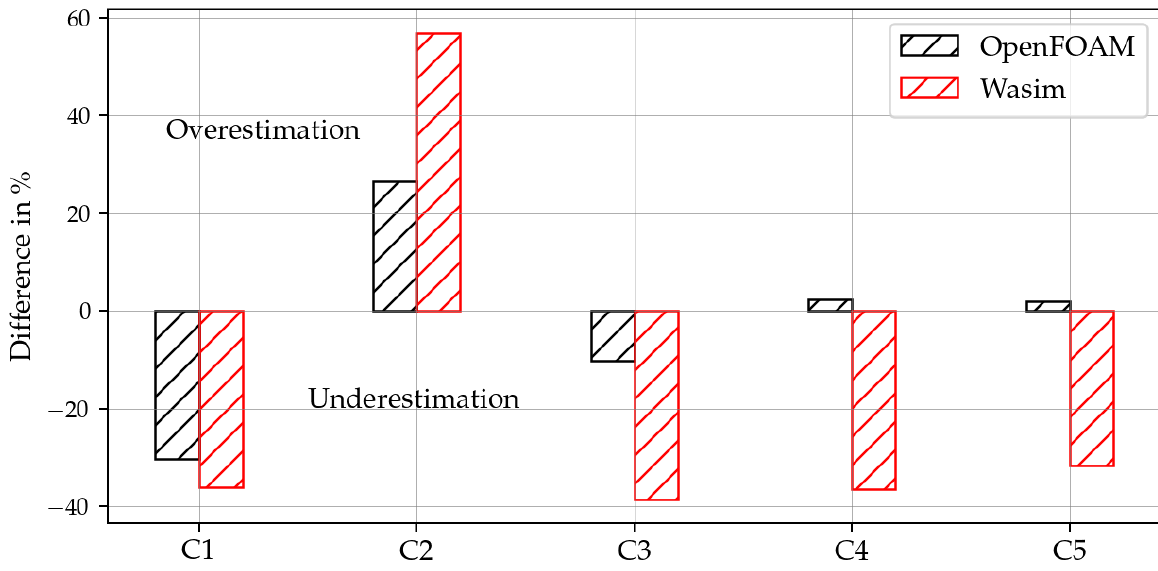
Figure 30. Difference of numerical and experimental heave transfer functions for the KRISO con- tainership.